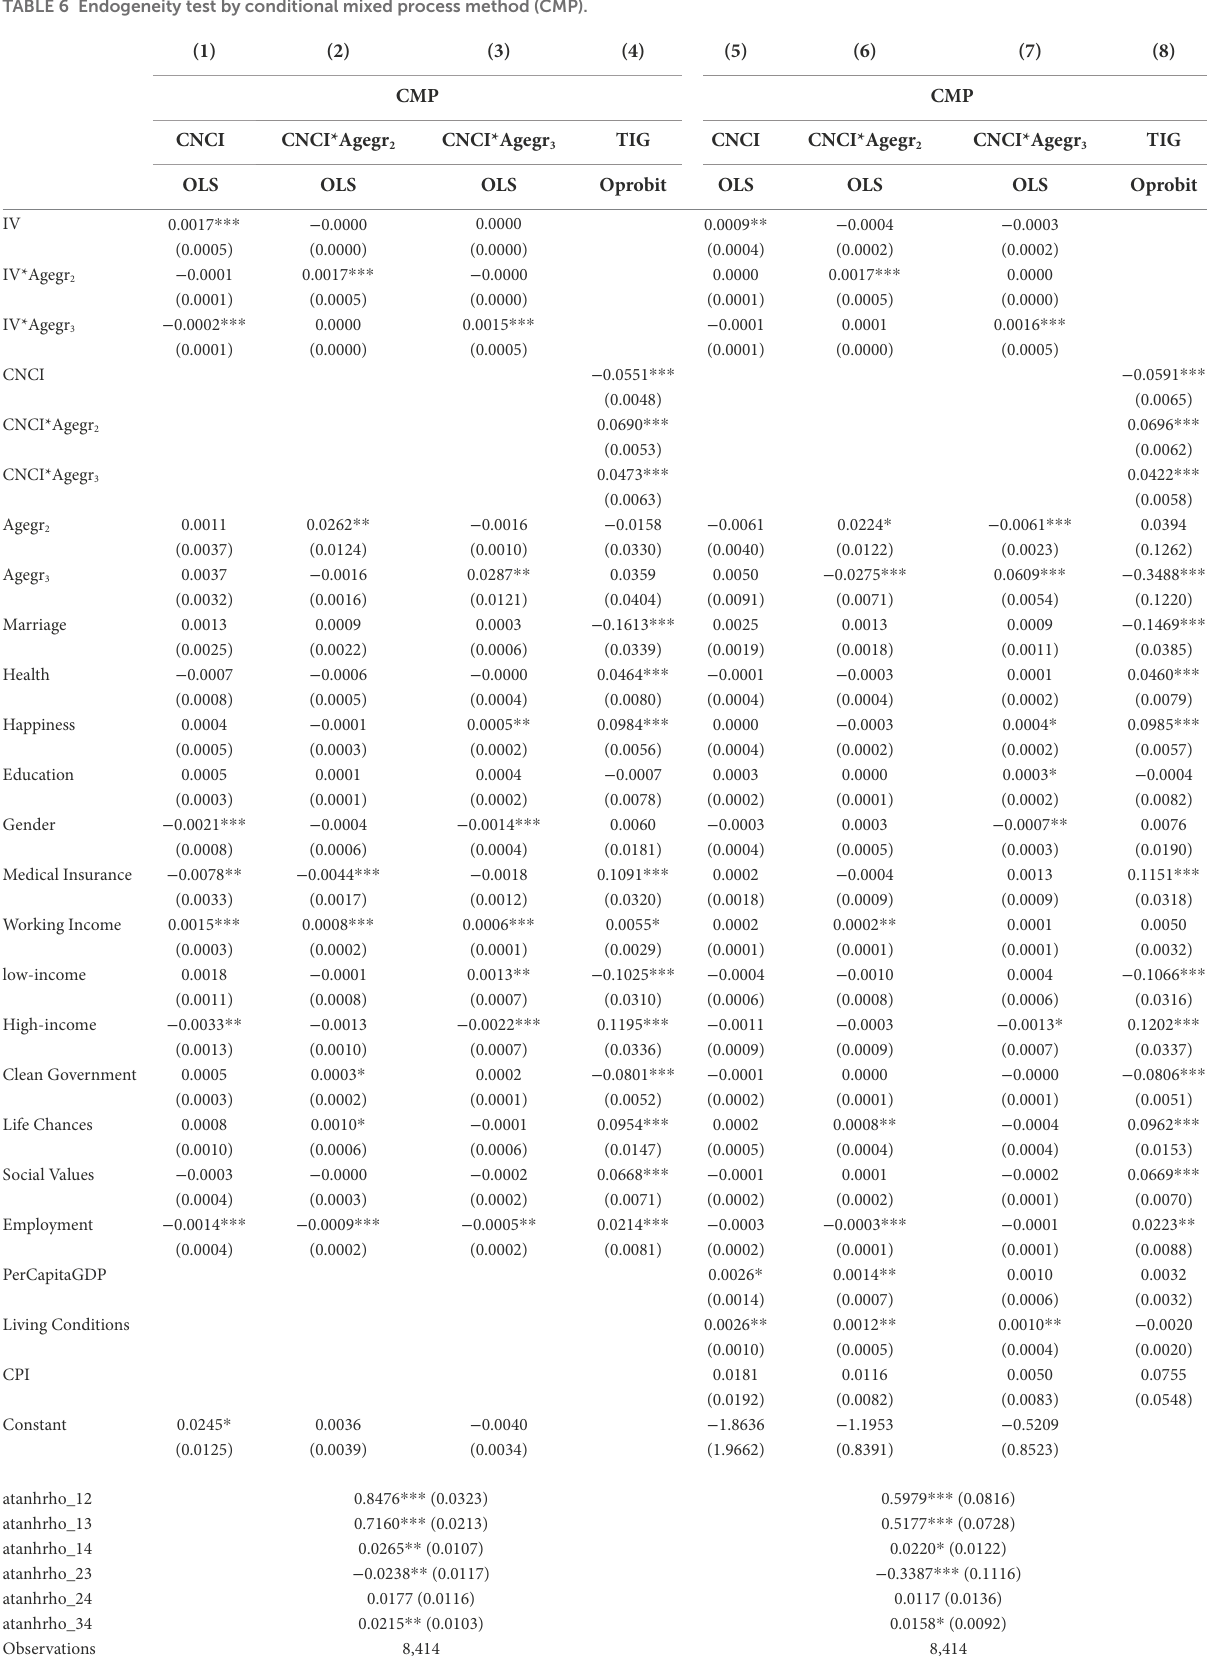
TABLE 6 Endogeneity test by conditional mixed process method